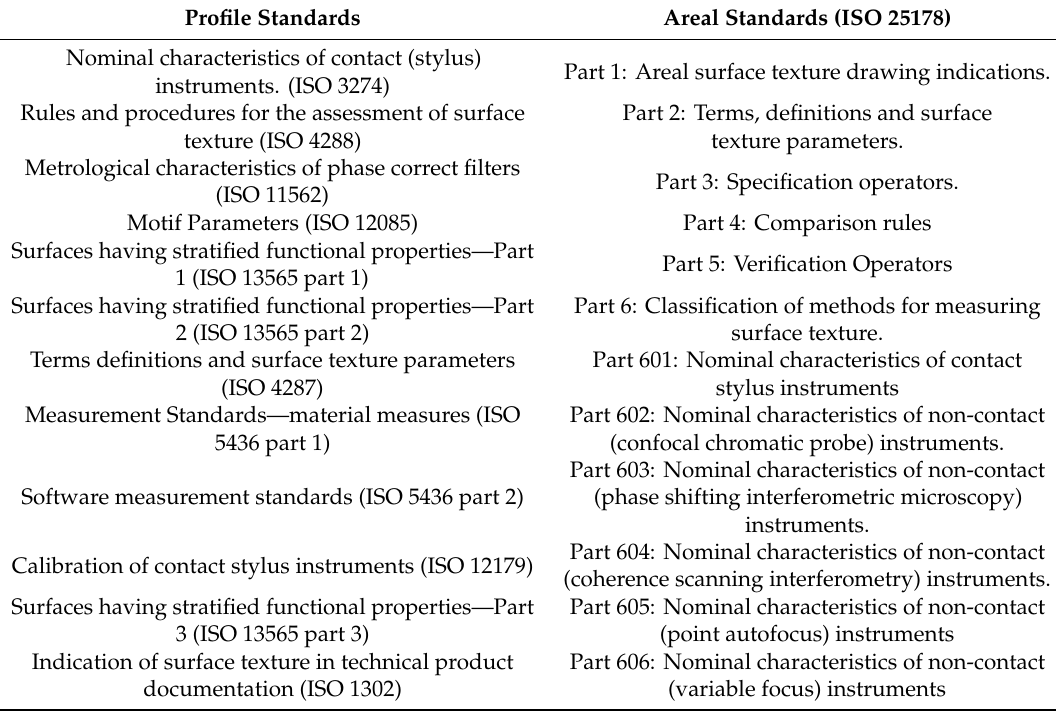
Table 1. A summary of the ISO guidelines governing profile and areal measurement of surfaces